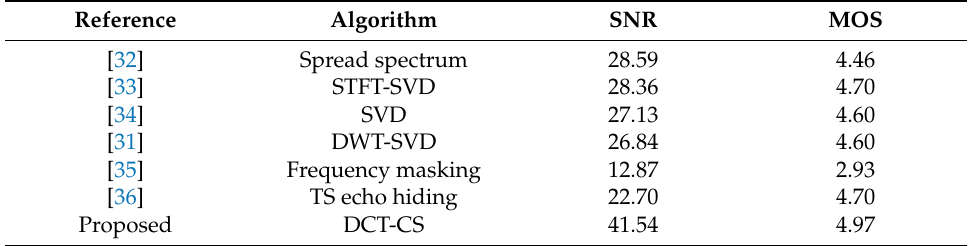
Table 3. Comparison of SNR and MOS between the proposed method and several recent